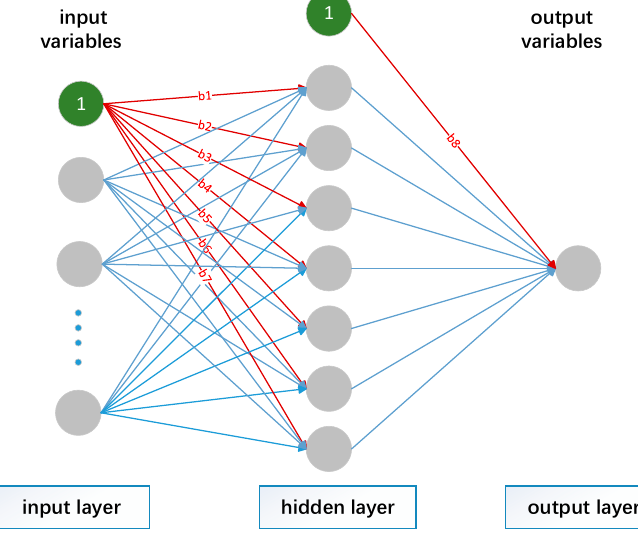
Figure 2. Basic structure of back-propagation neural network.